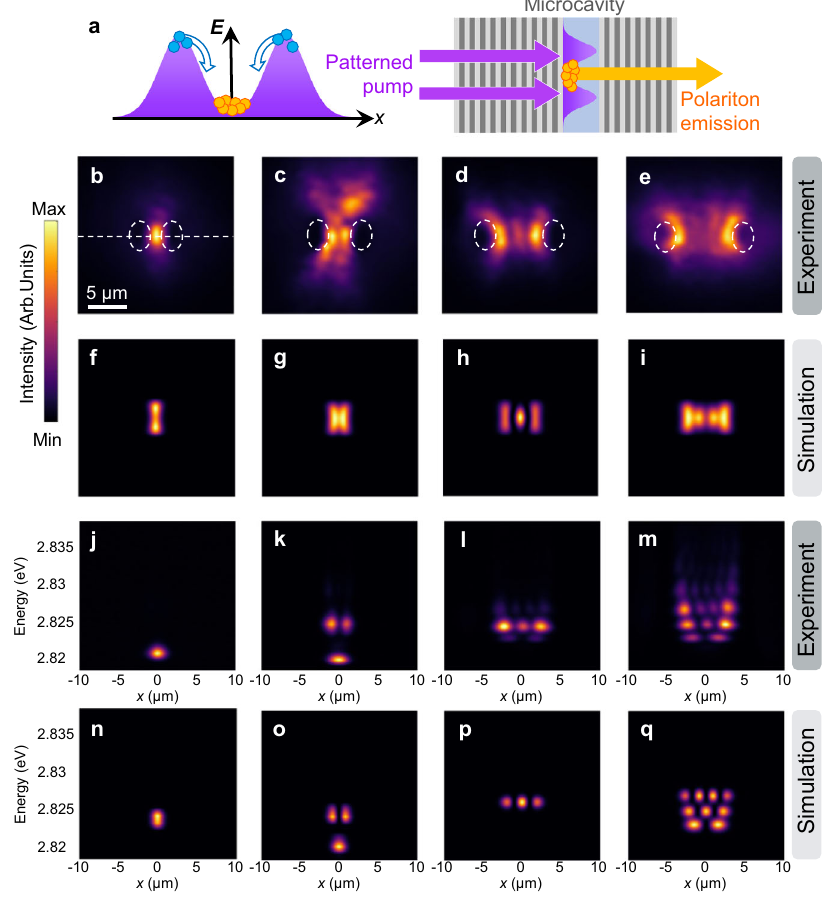
Fig. 1 | Schematic structure and characterisationofone-dimensionaltrapping. a Experimental scheme with the patterned pump incident on the substrate of a planar microcavity and the emission collected from the cavity surface. The left imageshowstwoneighbouringGaussianbeamsforminga1Dpotential.Thearrows denote the dominant fl ows of polaritons toward the bottom of the potential. b – e